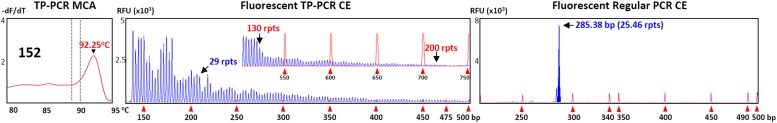
Premutation/full mutation mosaisicm in female sample #152. Fluorescent TP-PCR CE indicates the presence of a ∼130-repeat PM allele, and a FM allele as evidenced by the presence of fluorescent peaks extending beyond 200-repeats.